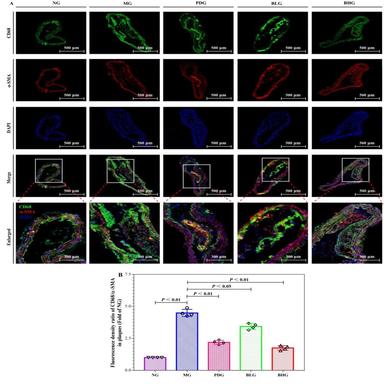
Representative immunofluorescence images of the aortic sections stained with the CD68 and α-SMA double antibodies (A), which appeared green and red for positive CD68 cells and α-SMA cells, respectively. Fluorescence density ratio of CD68/α-SMA in plaques (Fold of NG) (B).